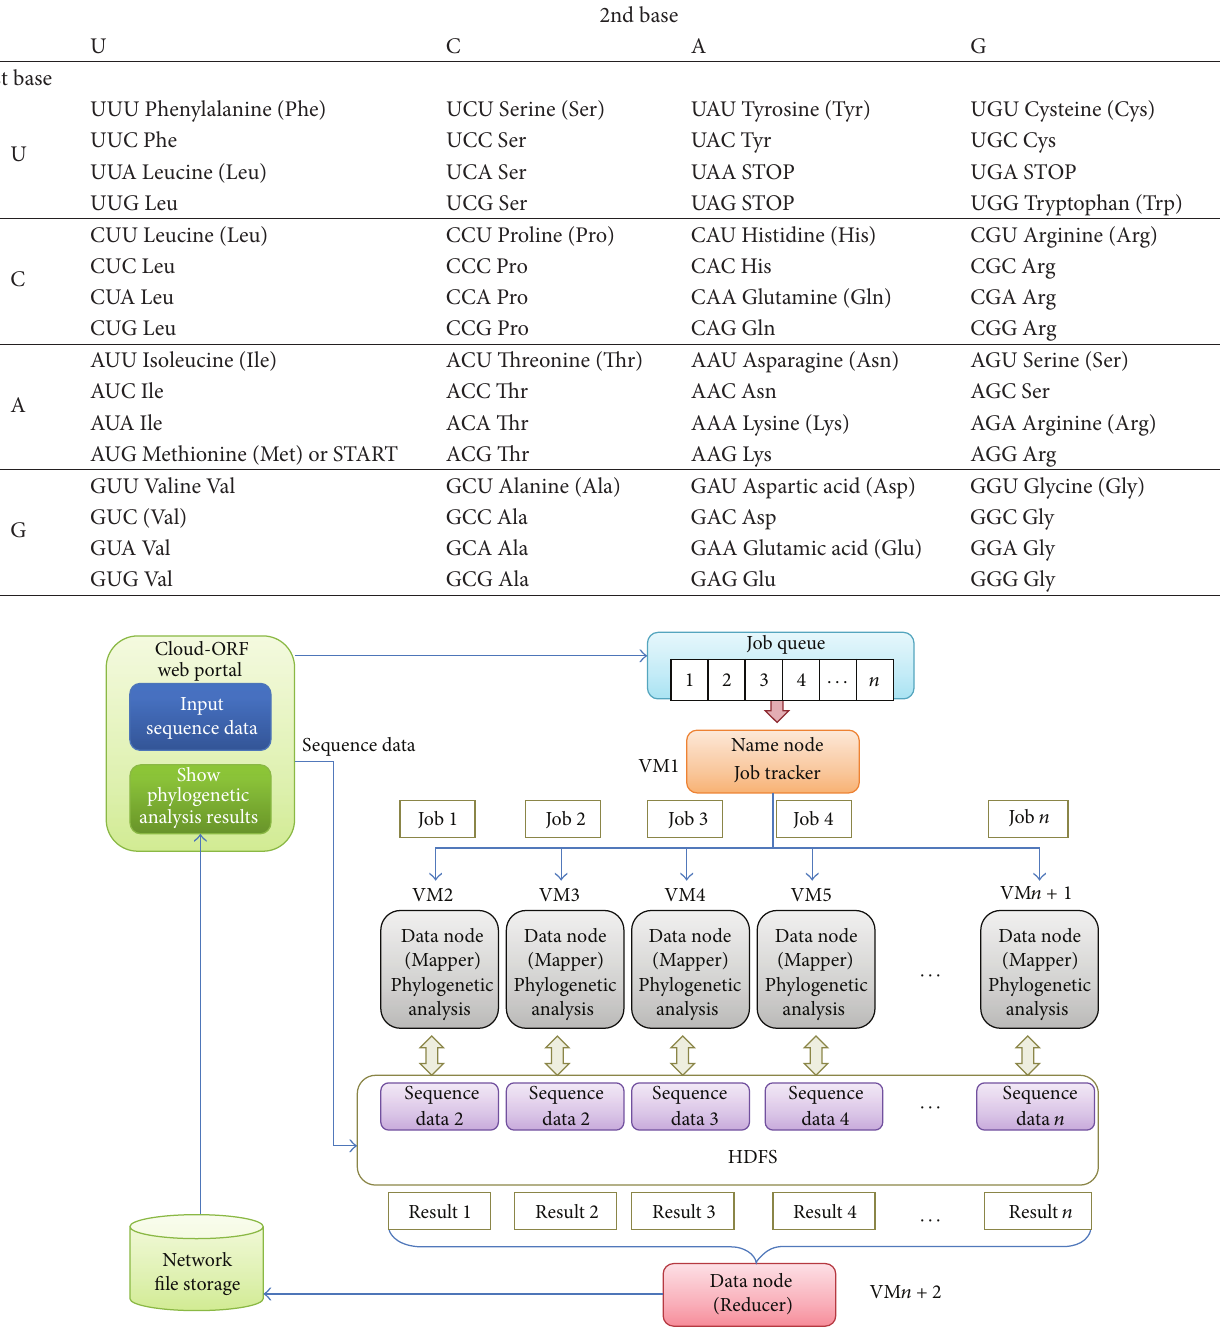
Table 1: The genetic code: nucleotides to amino acids.